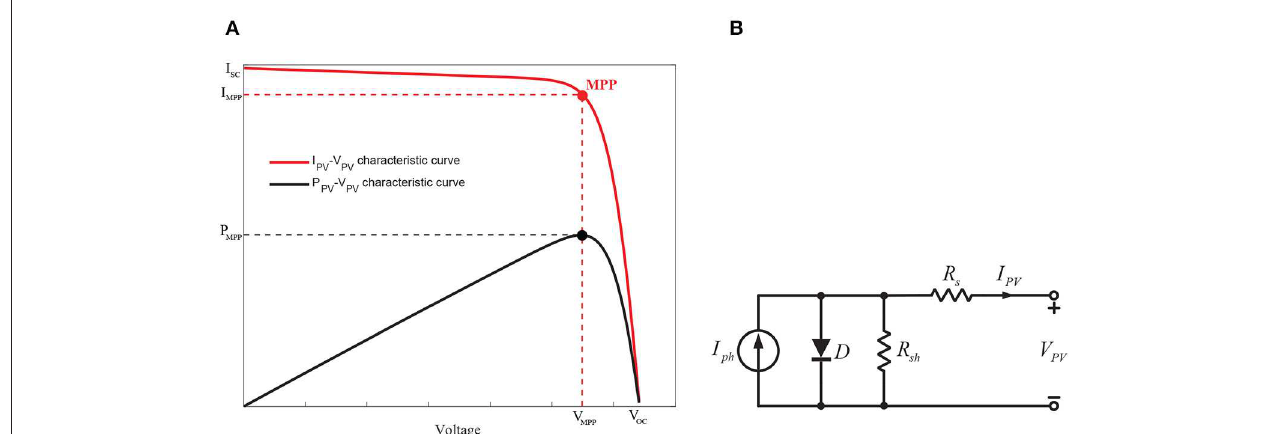
dependent on the current-voltage characteristic of this